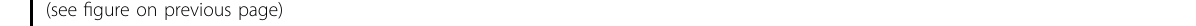
Fig. 5 Inhibition of miR-335 attenuates B-EV effects. The EVs were extracted from BMSCs transfected with miR-335 Inhibitor or Mock for 48 h, and treated on MC3T3 and MG63 cells for 24 h. A – B MC3T3 and MG63 cell viability was determined by MTT assay. C TUNEL staining was performed to determine apoptosis of MC3T3 and MG63 cells. D ALP activity in MC3T3 and MG63 cells was determined by ALP assay. E Alizarin red staining was performed to validate MC3T3 and MG63 bone differentiation ability. F Immuno fl uorescence staining measured the expression of Col I in cells; G , H RT-qPCR and western blot assays were performed to determine mRNA and protein levels of α -SMA, OCN, GDF-10, and FGF-2. Data are expressed as mean ± standard deviation. Two-Way ANOVA and Tukey ’ s multiple comparisons test were used to determine statistical signi fi cance. * p < 0.05. Four independent experiments were